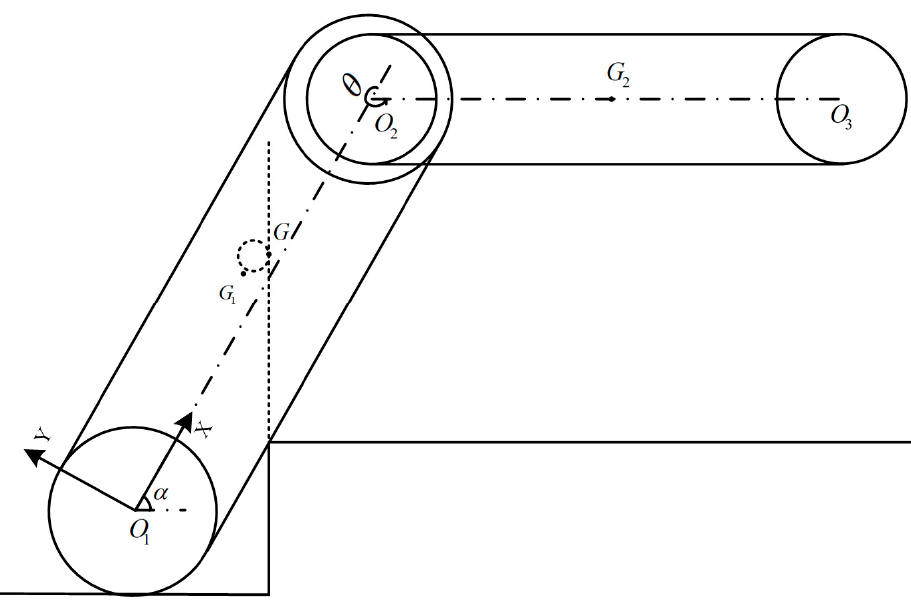
Figure 7. Robot centroid crossing the step boundary in forward obstacle crossing.